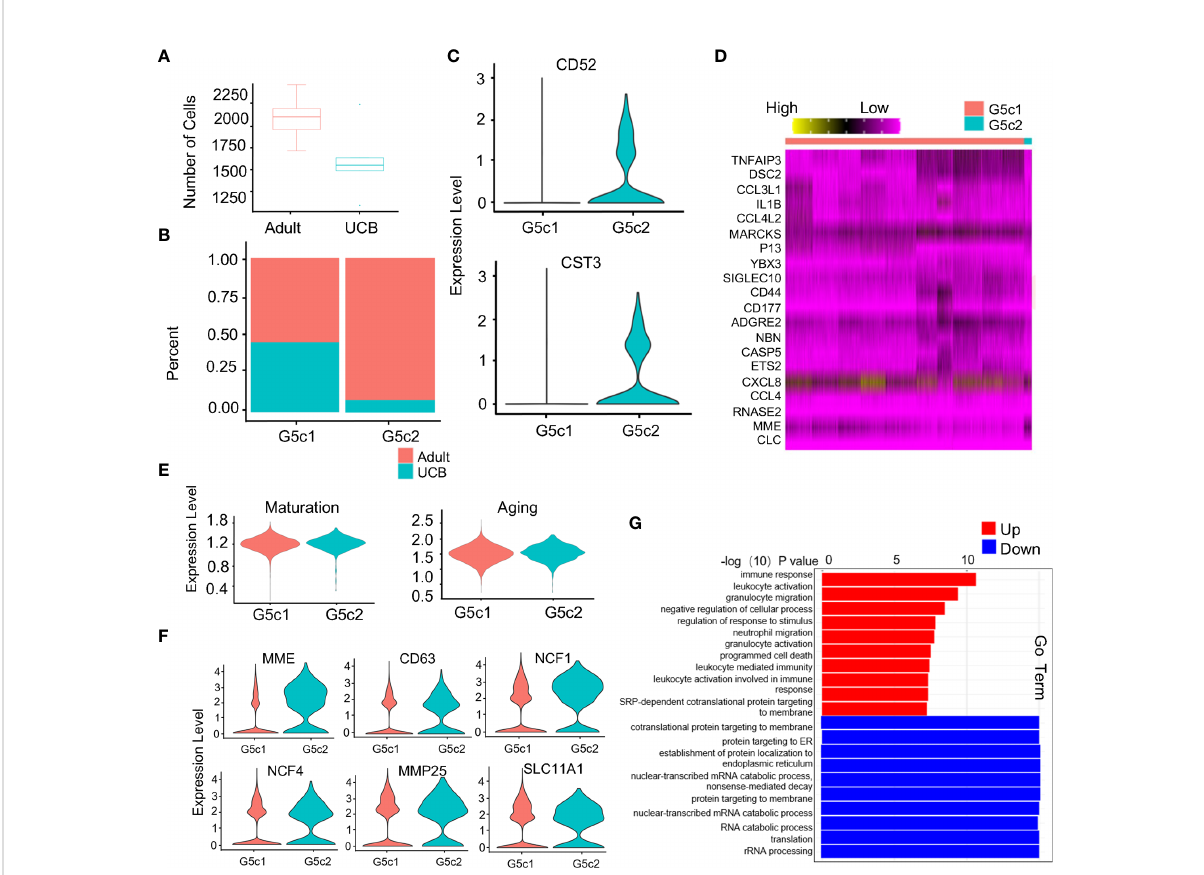
FIGURE 5 Speci fi c expression of G5c subset in neutrophils. (A) Scale diagram of G5c in healthy adults and UCB. (B) Proportions of G5c1 and G5c2 in deferent group. (C) Violin diagram of G5c2 speci fi c marker genes. (D) Heatmap of G5c1 and G5c2 differential genes based on DEGs. (E) Violin plots of the functional scores of activation and maturation of G5c1 and G5c2. (F) Violin diagrams of genes expression related with neutrophils four-level granules in G5c2. (G) GO-BP analysis based on DEGs between G5c1 and G5c2. Gene cluster entries in red represent differentially expressed genes up-regulated, while gene cluster entries in blue represent differentially expressed genes